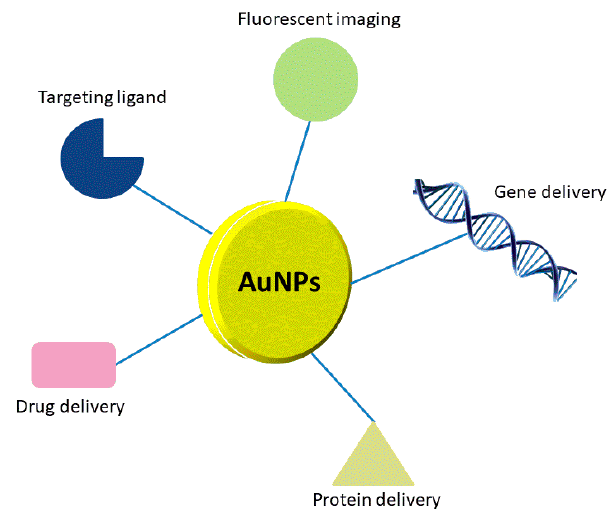
Figure 1. Various applications of Au NPs as carriers.